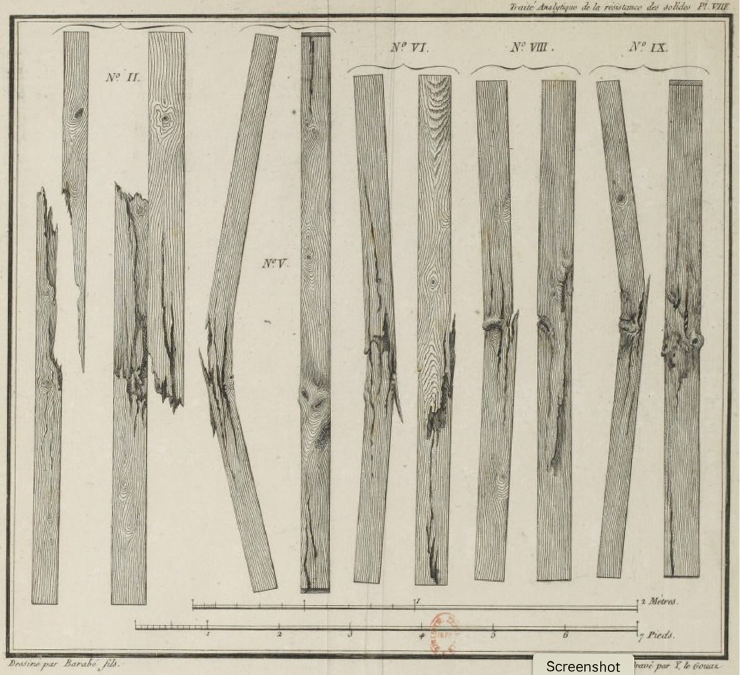
Figure 3. Engraving showing wooden beams broken by applying a longitudinal load using the apparatus shown in Figure 2a. From [42].